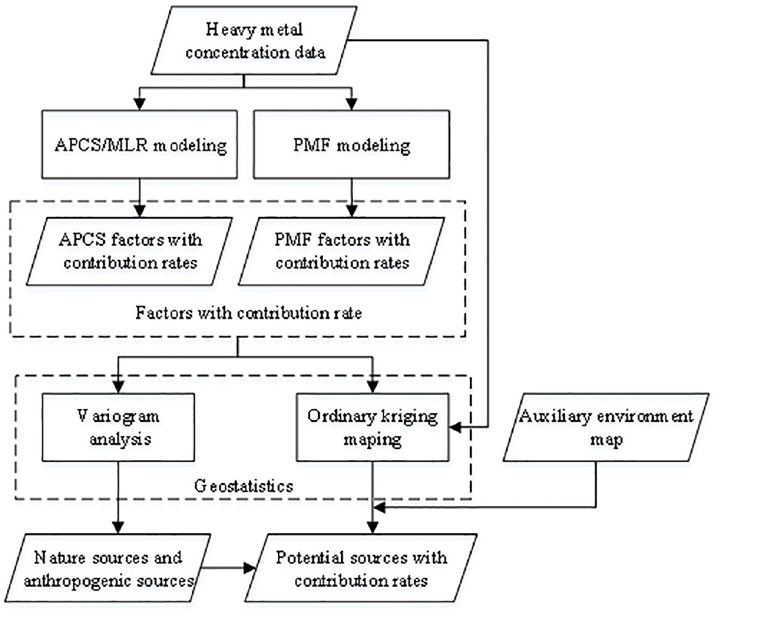
Fig 4. Source apportionment